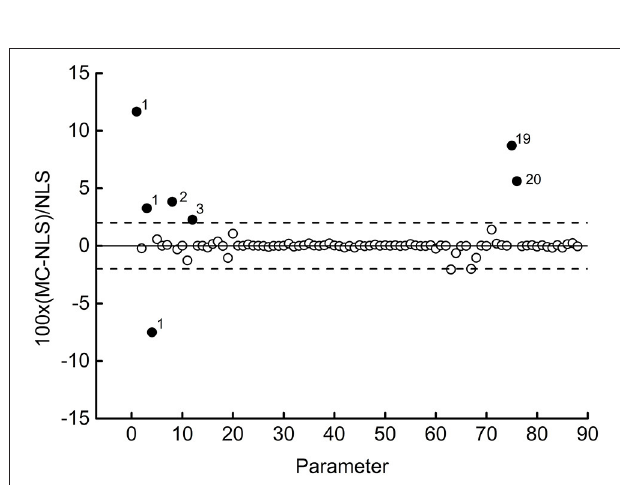
Figure 7 visualizes the near-convergence samplings of four selected parameters and serves as an example of the general